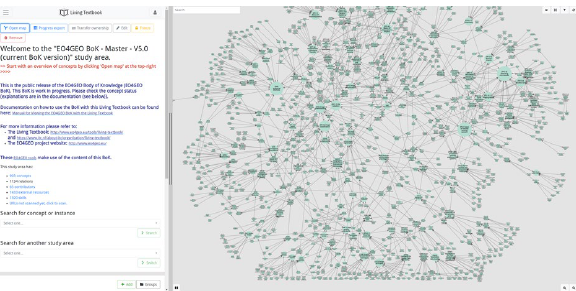
Figure 1 . The EO4GEO BoK in the Living Textbook 1